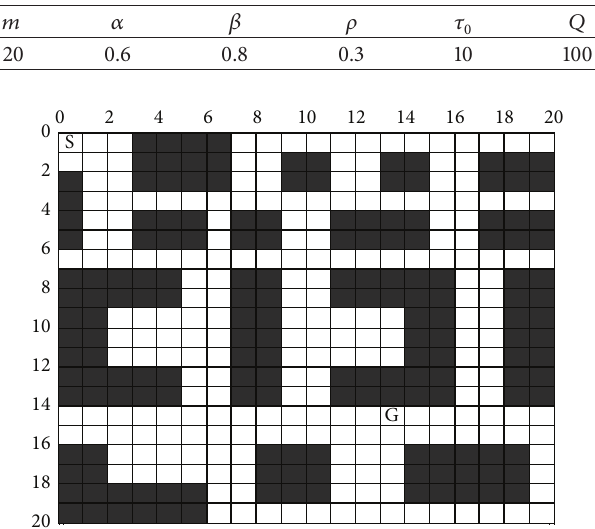
Table 1: Parameters of evolutionary ant colony algorithm.